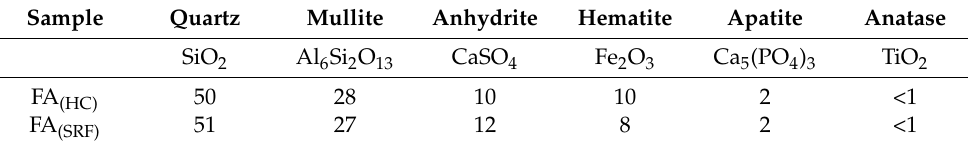
Figure 2. X-ray diffractograms of the studied fly ash samples.